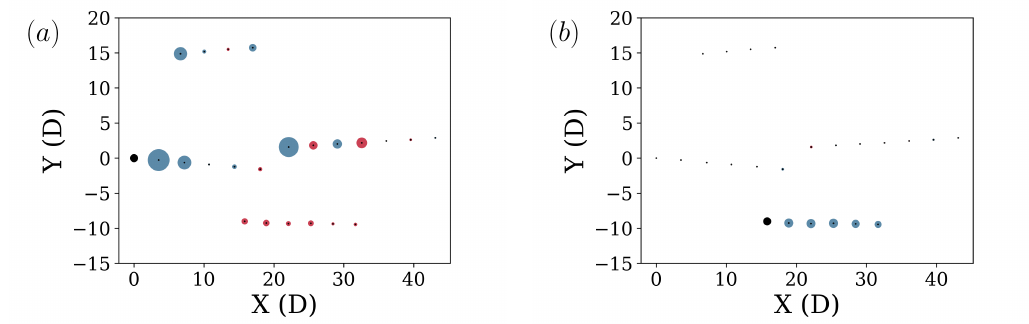
Figure 7. ( a ) Weight matrix w i , j in Equation (7) visualization for inflow from 330 ◦ ± 5 ◦ the linear statistical method. The value of the weight matrices for downstream turbines is plotted with respect to the black dot upstream Turbine B1. The size of the circle represents the magnitude of the weight matrix value and blue represents positive while red is negative. ( b ) Same as ( a ) with the upstream turbine of D1.